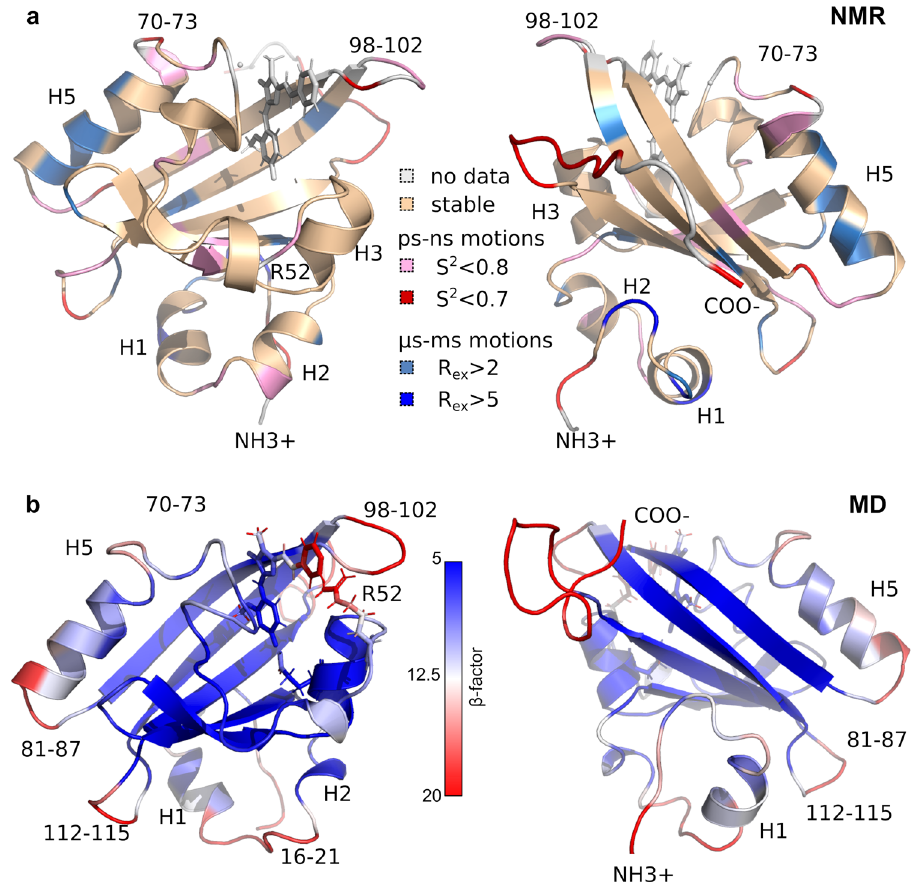
Fig. 1 Dynamics of FAST/N871b complex. a The NMR-derived spatial structure of FAST/ N871b is colored according to the generalized order parameters (S 2 ) of NH bonds (pink and red, ps-ns motions) and exchange contributions to the transverse relaxation (R ex , blue, µ s-ms motions). b The resulting FAST/ N871b structure after 100 ns MD simulations is colored according to the magnitudes of atom B-factors. Blue and red correspond to relatively stable and mobile regions,